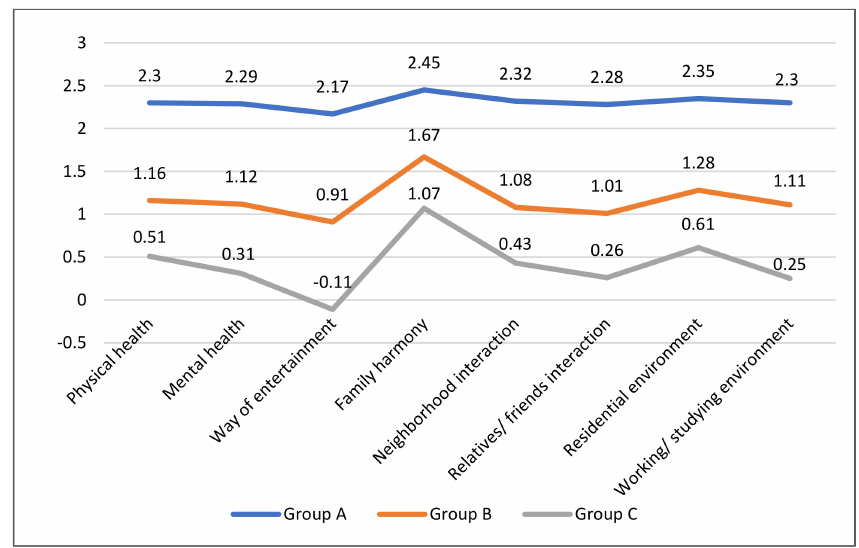
Figure 4. Comparison of the means of